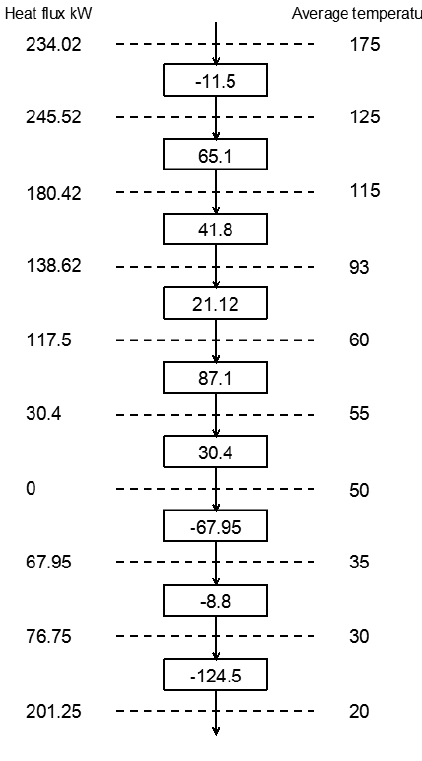
Figure 5. Heat cascade diagram.